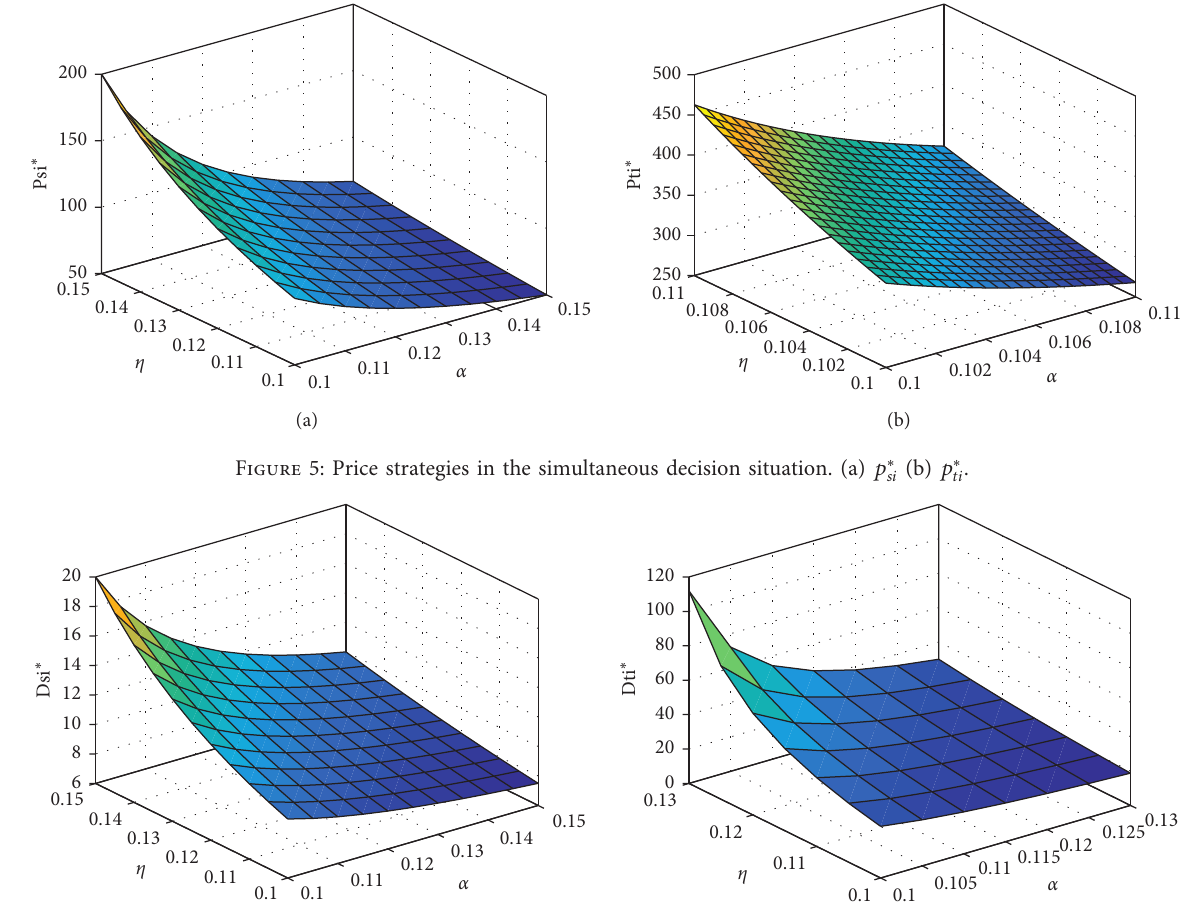
Figure 6: Demand functions in the simultaneous decision situation. (a) D ∗